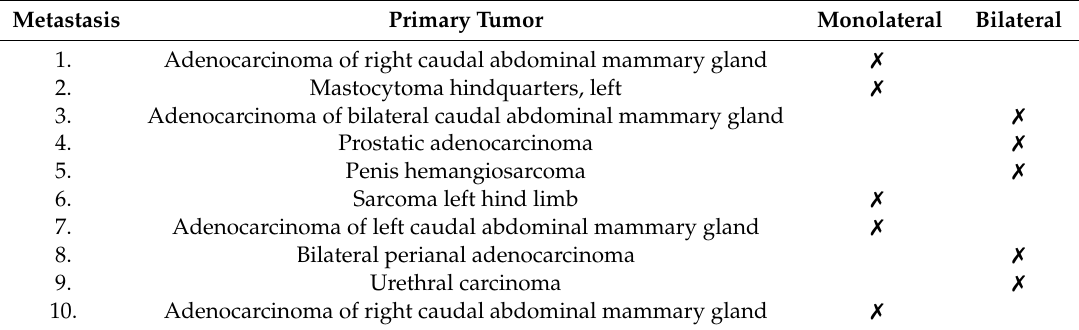
Table 1. Primary tumors in group B patients with lymph node